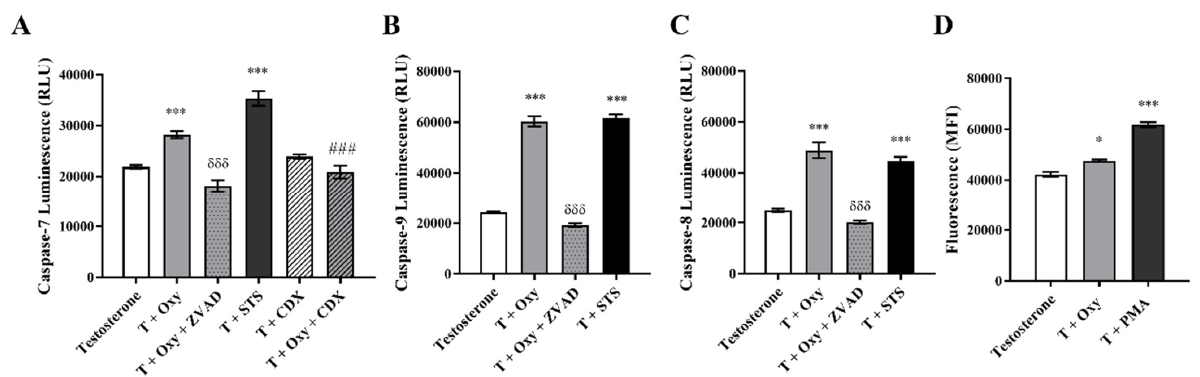
Figure 3. Involvement of apoptosis in the effects induced by Oxy on sensitive breast cancer cells.